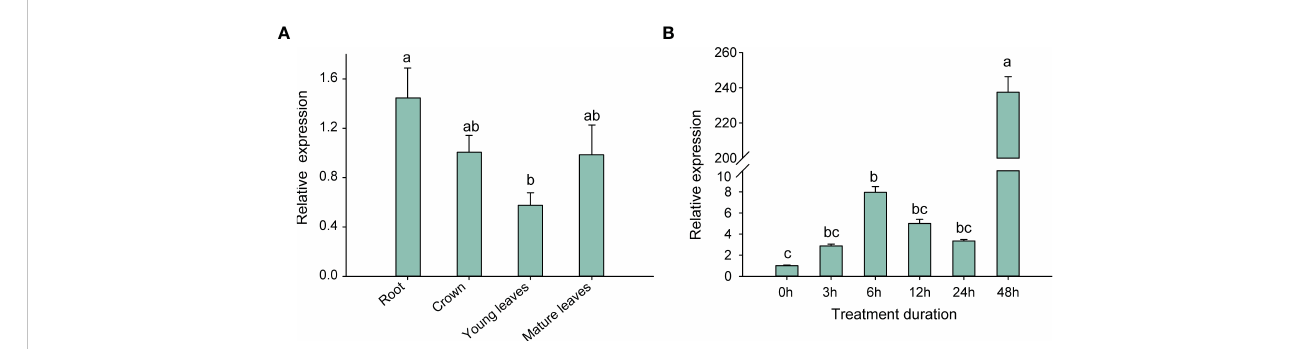
FIGURE 6 Expression levels of strawberry HXK1 in different tissues and variation under 20% PEG-6000 simulated stress condition. (A) Relative levels of FpHXK1 transcripts in different tissues based on RT-qPCR. (B) Relative FpHXK1 gene expression level in response to 20% PEG-6000 exposure. Values were presented as mean ± SEM of at least three biological repetitions. Statistically signi fi cant differences among samples were tested by Tukey ’ s test, signi fi cantly different (p< 0.05) were indicated by different letters, as determined by a two-way analysis of